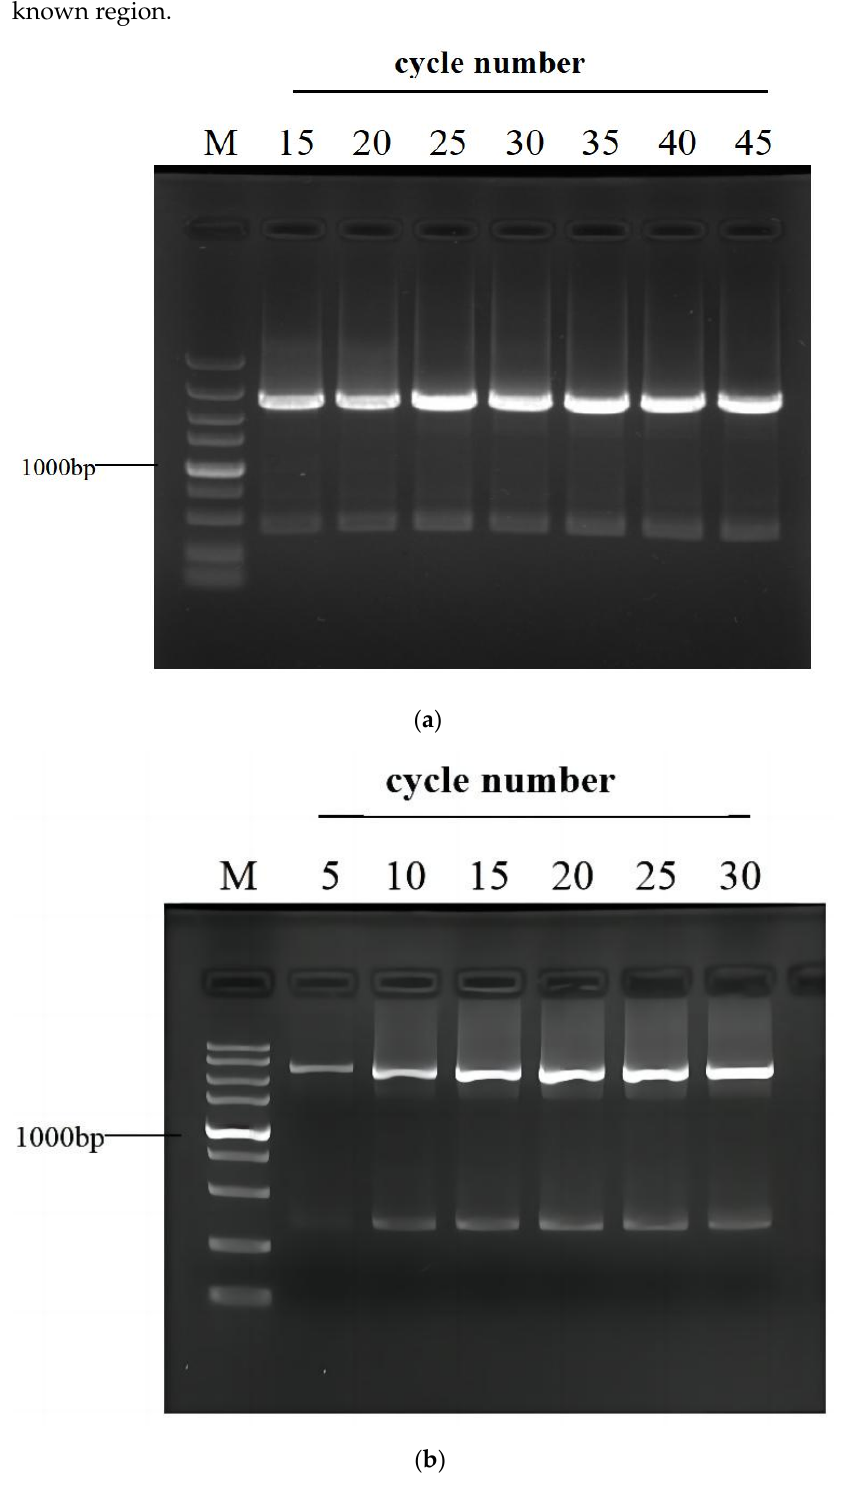
Figure 3. Effects of cycle number on ( a ) Secondary or ( b ) tertiary PCR. The primary amplification of target gadR was performed as shown in Table 2. The numbers on the top of the electropherograms represent PCR cycle numbers. Lane M: DNA 5000 Marker (5000, 3000, 2000, 1500, 1000, 750, 500, 250, and 100 bp).